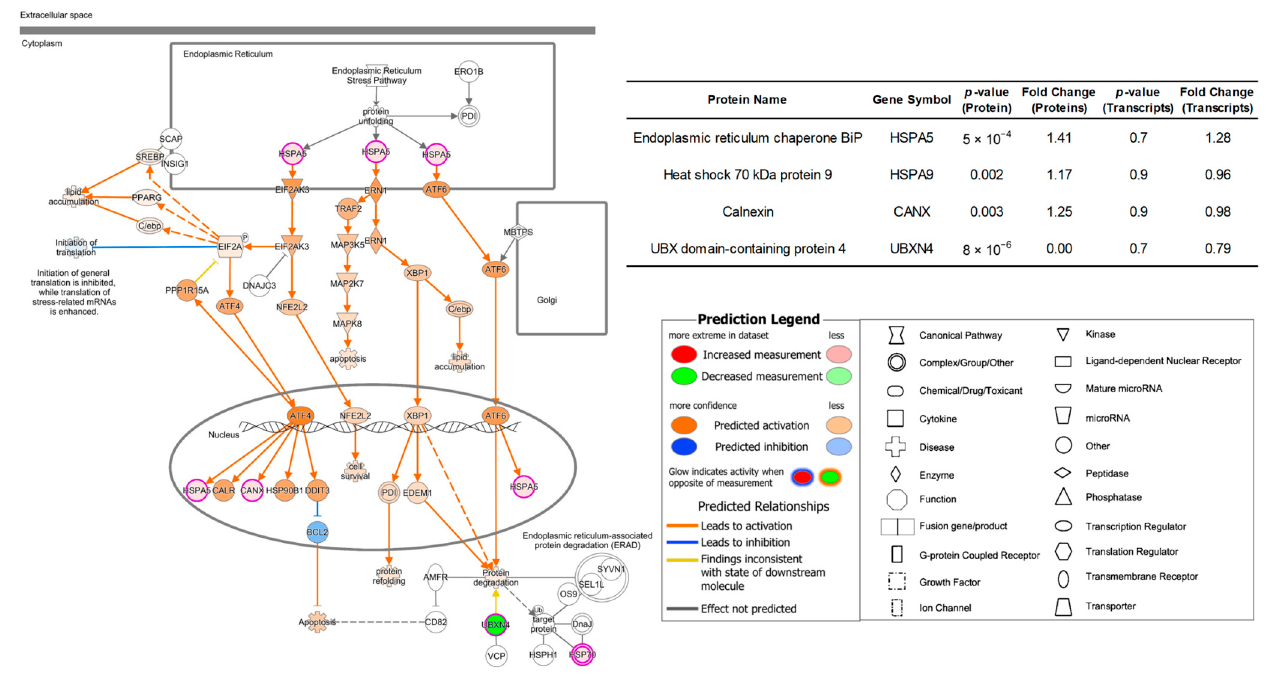
Figure 6. Activated unfolded protein response pathway of protein expressions in CRL cell line cultivated by Plasmax in comparison with DMEM. Color codes and symbols are the same as Figure 2. The inset table provides the p -values and fold-change numbers of proteins and their corresponding transcripts that are involved in this pathway.